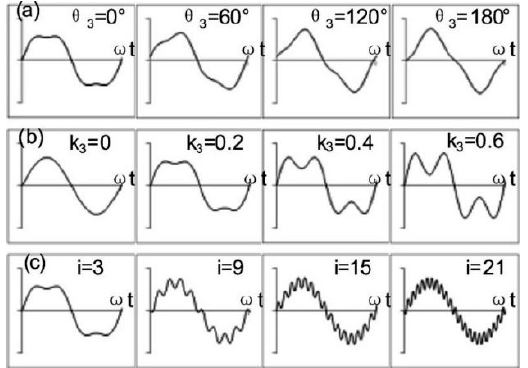
Figure 2. Flux waveform trends at different harmonics. ( a ) Based on i = 3, k i = 0.2, θ i ∈ [ 0 ◦ ,180 ◦ ] , the influence of θ i on waveform. ( b ) Based on i = 3, θ i = 180 ◦ , k i ∈ [0, 0.6], the influence of k i on the waveform. ( c ) Based on θ i = 180 ◦ , k i = 0.2, i ∈ { 3,9,15,21 } , the influence of i harmonic on the waveform.